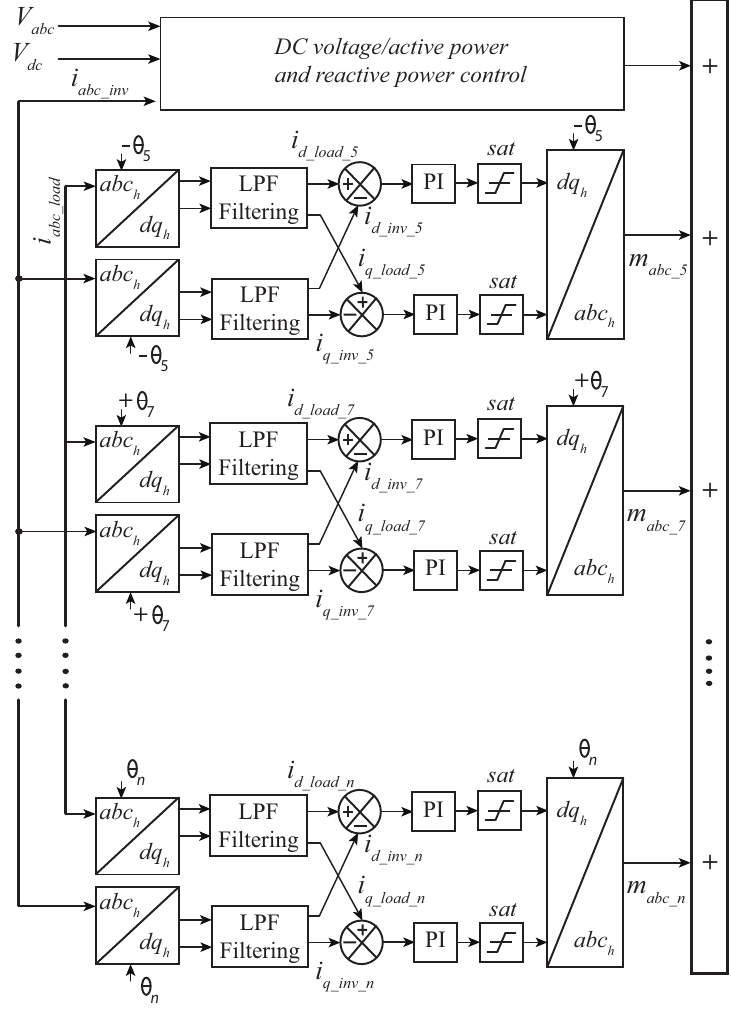
Figure 3. Selective harmonic compensation based on the synchronous reference